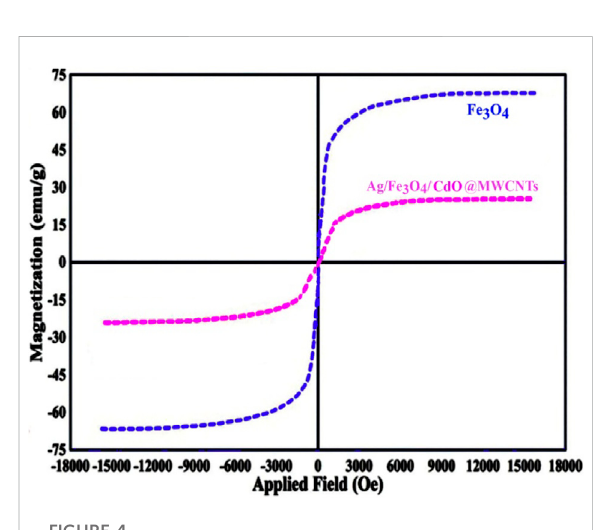
FIGURE 4 VSM analysis of the green Ag/Fe 3 O 4 /CdO@MWCNT MNCs.